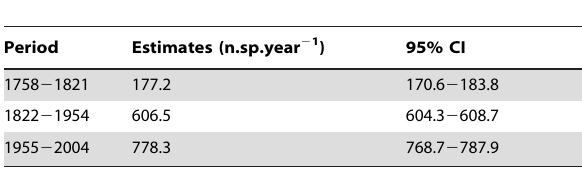
Table 1. Growth in European taxonomic inventory